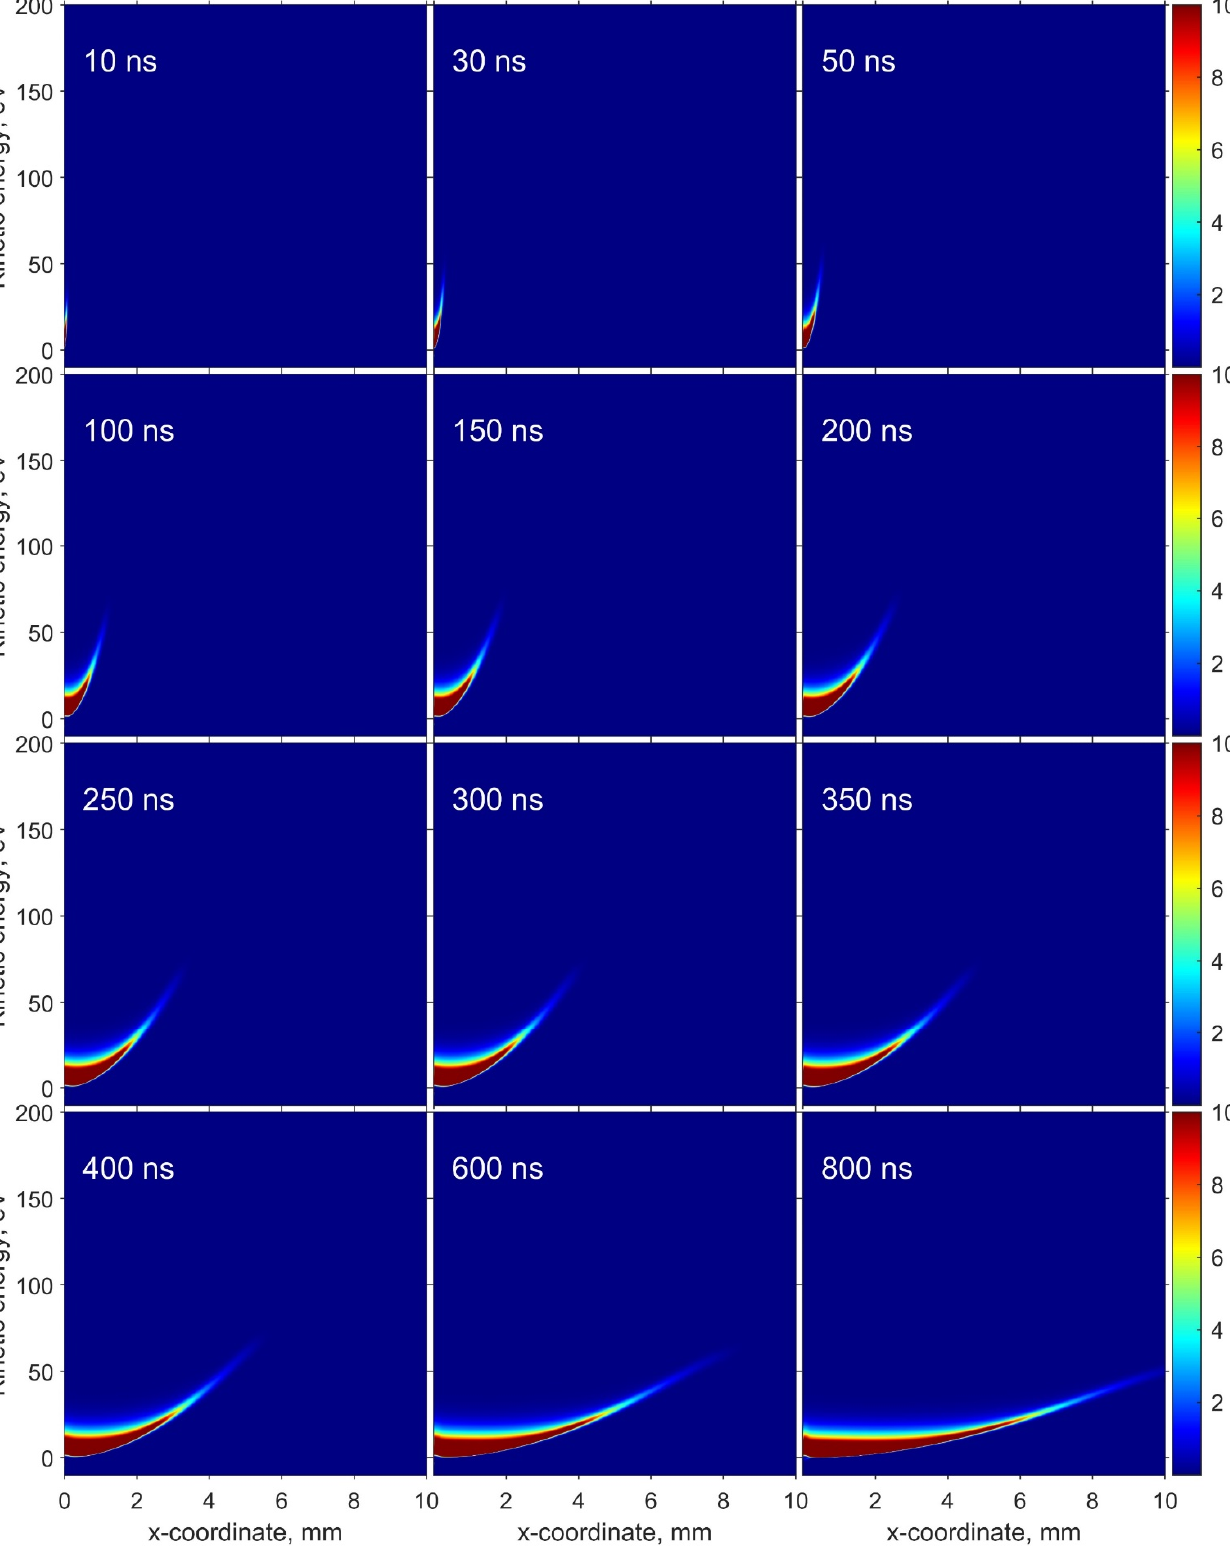
Figure 5. Density plots of the ion (Zn + ) distribution function given at selected time steps for the vacuum breakdown simulation in a diode with zinc cathode. The scale is linear in 10 39 s/(kg m 4 ) units.